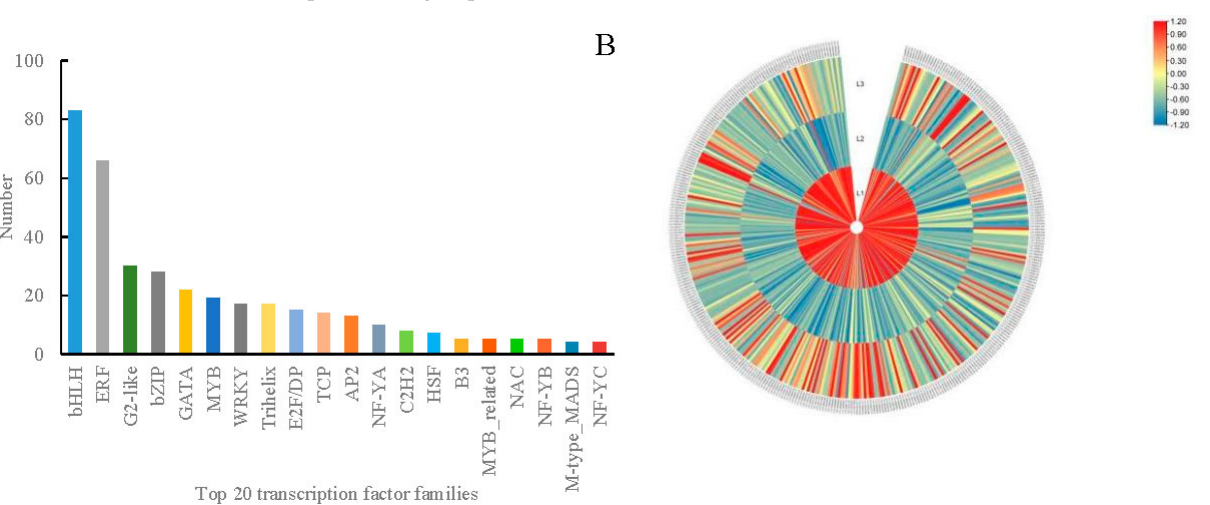
Figure 5. Analysis of differentially expressed transcription factors in walnut embryos at different developmental stages. ( A ) Differentially expressed transcription factor families (top 20); ( B ) cluster analysis of differentially expressed transcription factors based on FPKM. L1 was 60, L2 was 90, and L3 was 120 DAP. The color scale represents the calculated Z-score. Red and blue indicate higher and lower abundances,